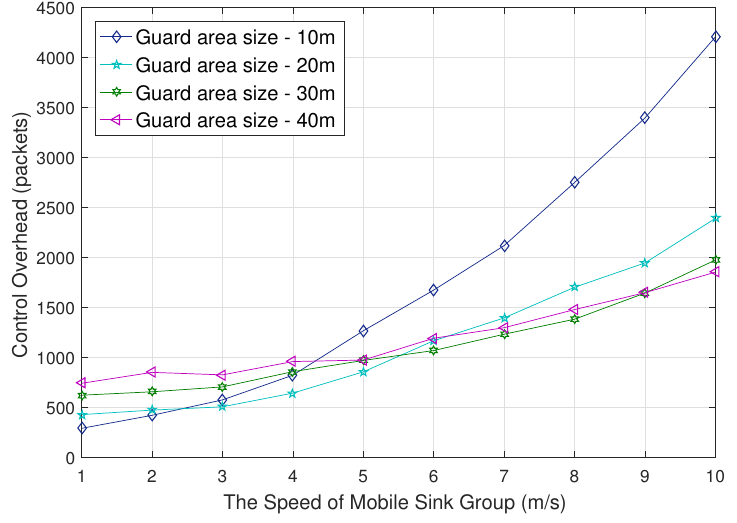
Figure 13. Control overhead impacted by guard area